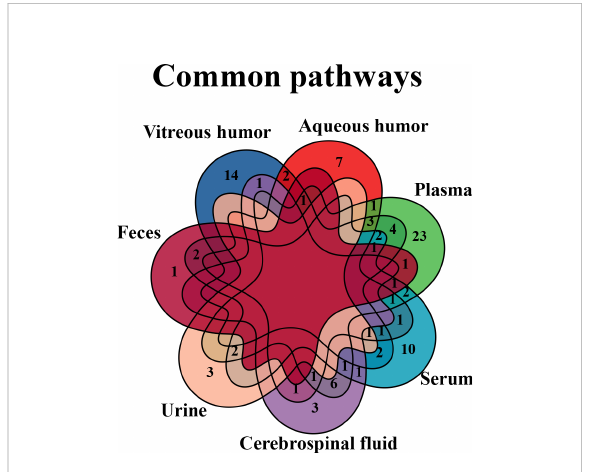
FIGURE 10 Venn diagram of common pathways in various biological samples. Common changed pathways of DR in various biological samples, but retina is excluded, were analyzed by Venn diagram.